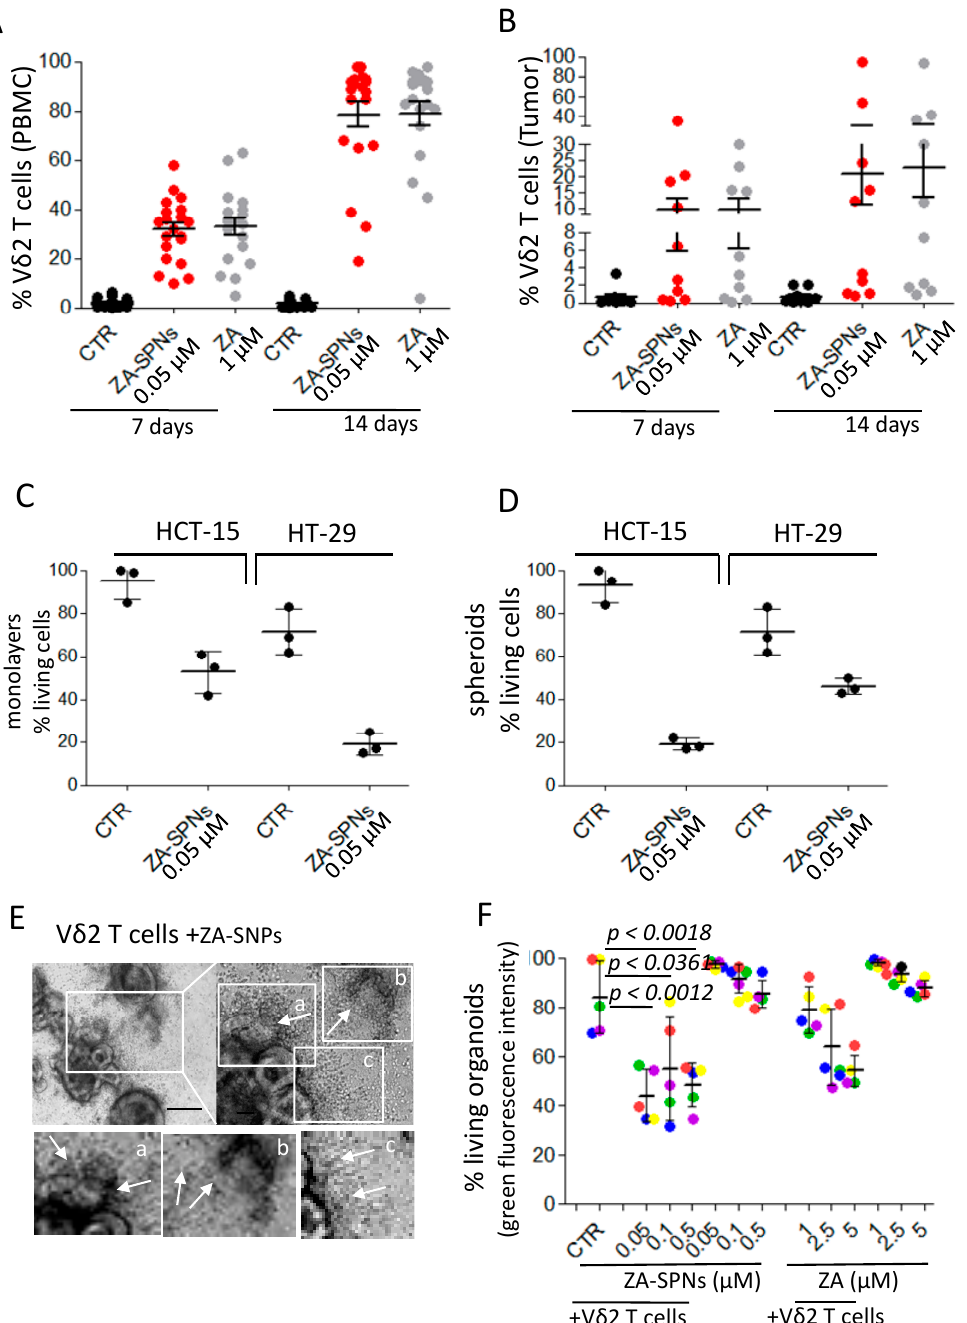
Figure 5. ZA-SPNs triggered the expansion of CRC patients’ V δ 2 T lymphocytes to be able to kill CRC spheroids and autologous organoids. ( A ) PBMC from CRC patients were cultured with ZA-SPNs (0.05 µ M) or soluble ZA (1.0 µ M) and 10 ng / mL (30 IU / mL) IL-2. The percentage of V δ 2 T lymphocytes was evaluated using FACS analysis on days 7 and 14. V δ 2 T cells in the starting PBMCs: 1.4 ± 1.6%, mean ± SD of 20 patients. ( B ) Tumor cell suspensions were cultured as in (A), and V δ 2 T lymphocyte expansion was determined on days 7 and 14. Results are expressed as percentages of V δ 2 T lymphocytes as mean ± SD of 10 patients’ specimens. V δ 2 T cells in the starting tumor-derived populations: 0.04 ± 0.05% (mean ± SD of 10 patients). ( C , D ) HCT-15 or HT-29 as adherent cells (C) or spheroids (D) were incubated with ZA-SPN-expanded V δ 2 T cells obtained from the PBMCs of three CRC patients. ZA-SPNs (0.05 μ M) were further added or not (CTR) at the onset of the 48 h assay. E:T ratio was 3:1. Data expressed as a percentage of living CRC cells (crystal violet staining) as mean ± SD of six replicates/condition in three independent experiments. ( E )